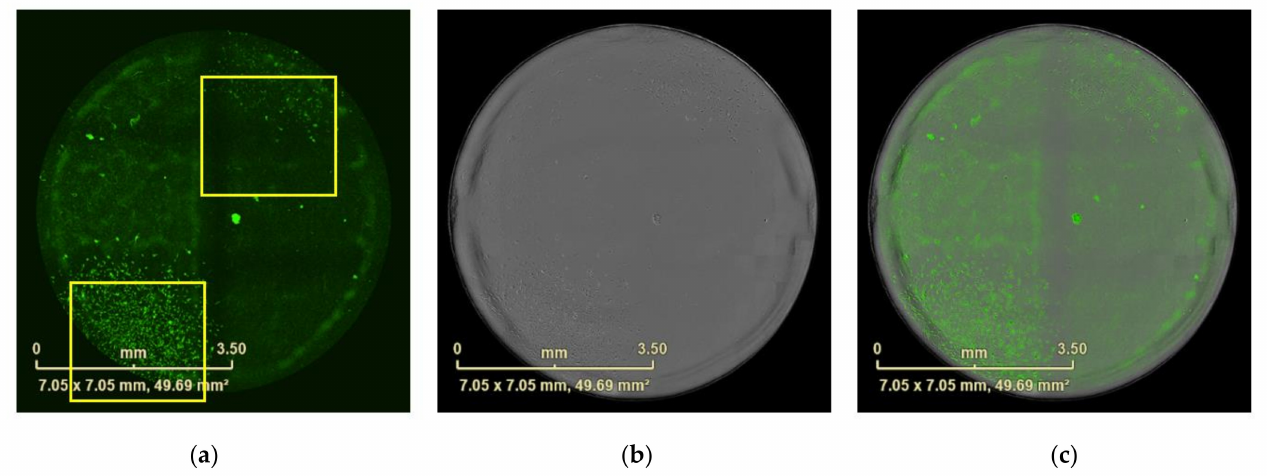
Figure 7. Wells with separated monoclonal cells imaged after 12 days incubation ( a – c ). ( a ) Well scanned by eGFP fluorescence. ( b ) Bright field image. ( c ) Overlap of fluorescence image with bright field image. The yellow squares show two separated monoclonal cells, all scale bars represent 3.5 mm. Figure 13. Imaging of the marked clones after elimination. ( a ) Image from Figure 11a after